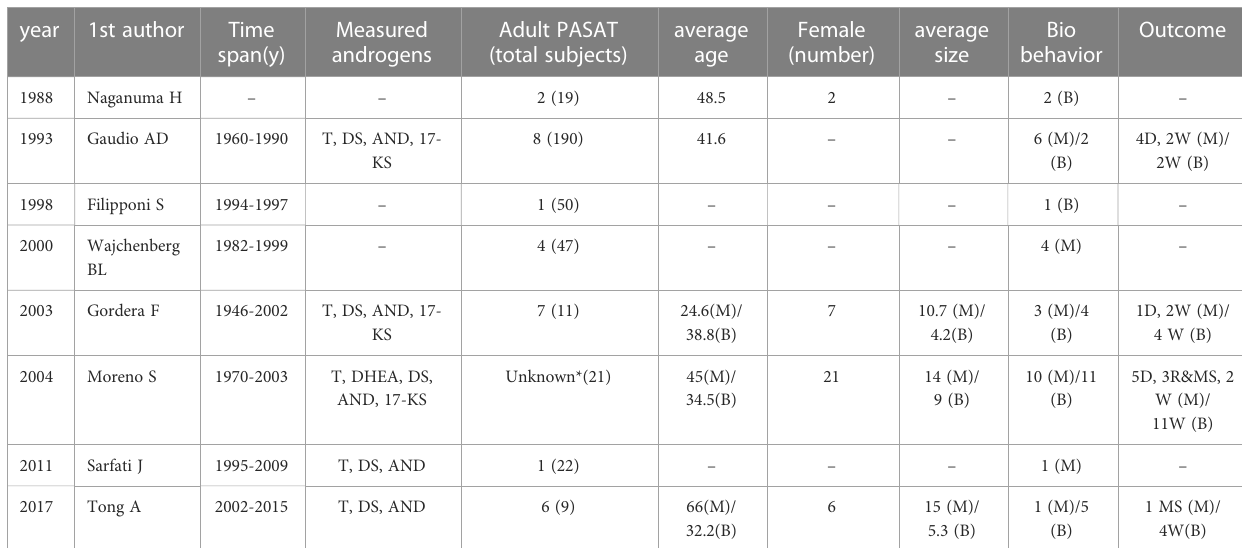
TABLE 3 Summary of articles containing adult PASAT.